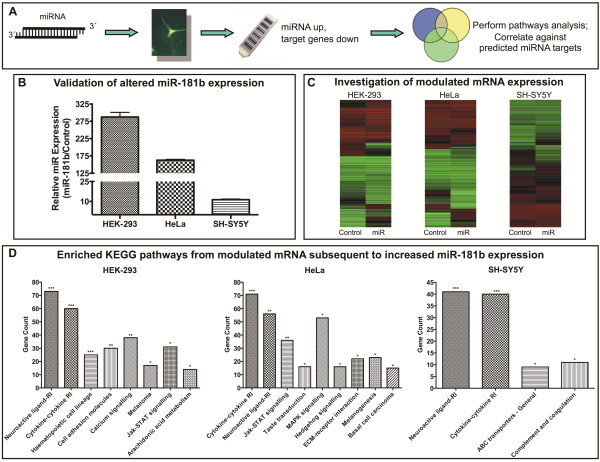
Biological processes affected by miR-181b over-expression in cell culture via miR-181b transfection. Panel A demonstrates the experimental design for the identification of genes subject to PTGS by increased miRNA concentrations. Canonical miRNA function results in a subsequent decrease in mRNA expression levels detected by whole-genome expression analysis using microarrays. These differentially expressed genes are subsequently utilised for DAVID pathways analysis and correlated against predicted miRNA targets. Panel B shows the increase in miR-181b expression levels in comparison to controls for HEK-293, HeLa and SH-SY5Y cell types. Panel C shows a clustered-by-gene heat map from whole genome expression microarray data from each cell model, with n=2 per condition. Panel D shows the significantly enriched KEGG pathways for each cell type in response to increased intracellular miR-181b levels. RI: receptor interaction; ECM: extracellular matrix; MAPK: mitogen-activated protein kinase.